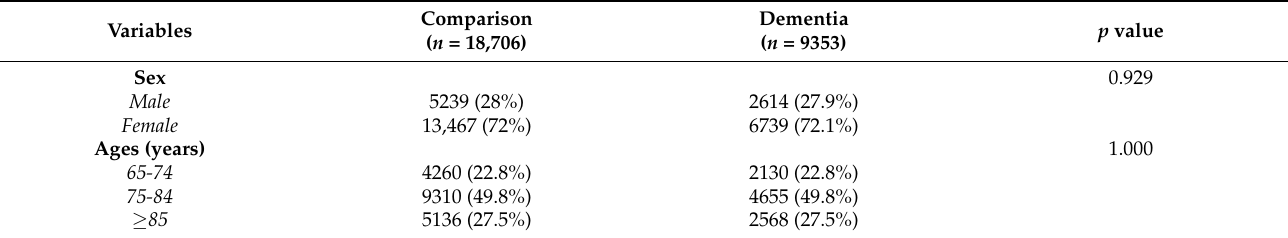
Table 6. Detailed characteristics of the cohort dataset for sensitivity